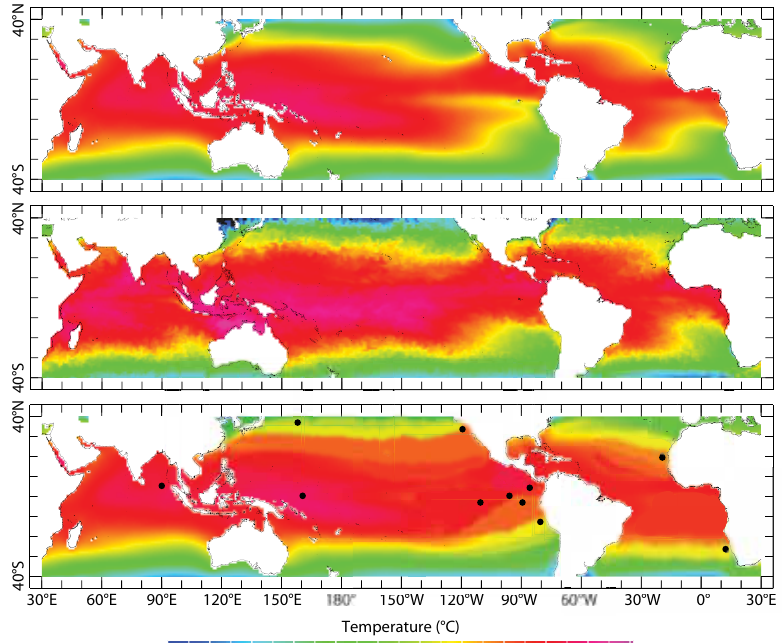
figure 2.8. comparison of modern annual aver- age sea surface temperature (top; locarnini et al., 2010), with sea surface temperature during the January, 1998, el niño event (middle; carton and giese, 2008), and the pliocene annual average sea surface temperature (bottom). The pliocene recon- struction (representing ~4.6–3 million years ago) resembles a permanent el niño-like state, with a tropical warm pool in the pacific that was expanded relative to today both in the east-west and north- south directions. pliocene data come from ocean drilling sites (dots on bottom panel; see dekens et al., 2007, and references therein). courtesy of c. ravelo, University of california, santa